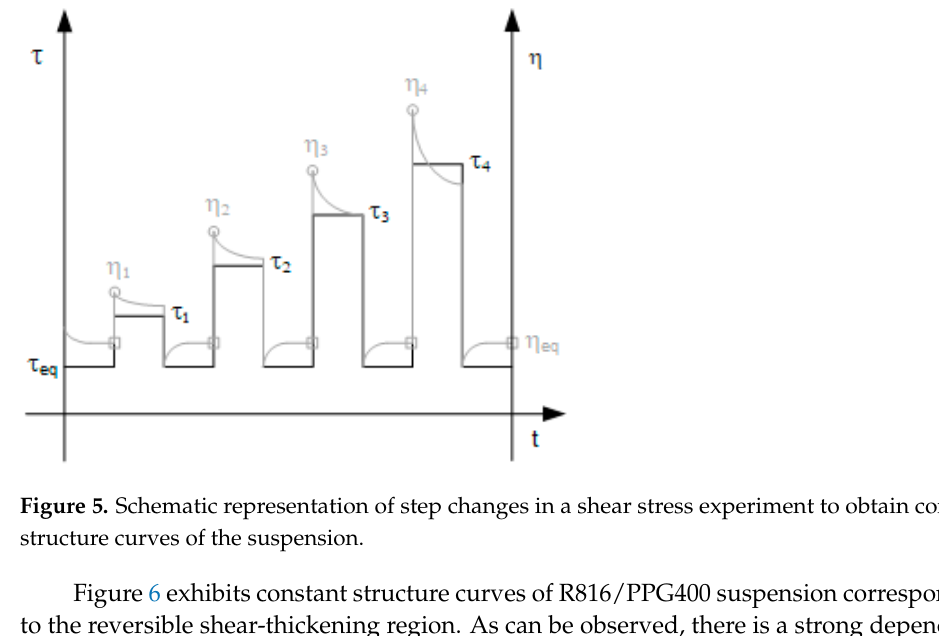
7 of 13 Figure 4. Variation of steady apparent viscosity with shear stress of the R816/PPG400 suspension. As it was pointed out before, the description of the viscous behavior of time-depend- ent fluids has been done in terms of the evolution of the internal microstructure that forms with the shear flow [5]. It is reasonable to expect that different structural levels be are achieved depending on the shear intensity. Cheng [40] proposed a rheological method to compare the microstructure strength achieved by the fluid at different shear stress values. As it is shown in Figure 5, Cheng’s method consists of applying consecutive step changes in stress from an equilibrium state τ eq ( ) to different stress values ( τ k , k = 1, …, n) and recording the peak values in viscosity ( η k , k = 1, …, n). In this way, the steady microstruc- ture corresponding to different τ eq -values can be characterized. Each step must be ap- plied just after the same reference steady viscosity value η eq ( ) is reached. In this way, initial viscosity values η k ( ) corresponding to each τ k refer to the same internal struc-